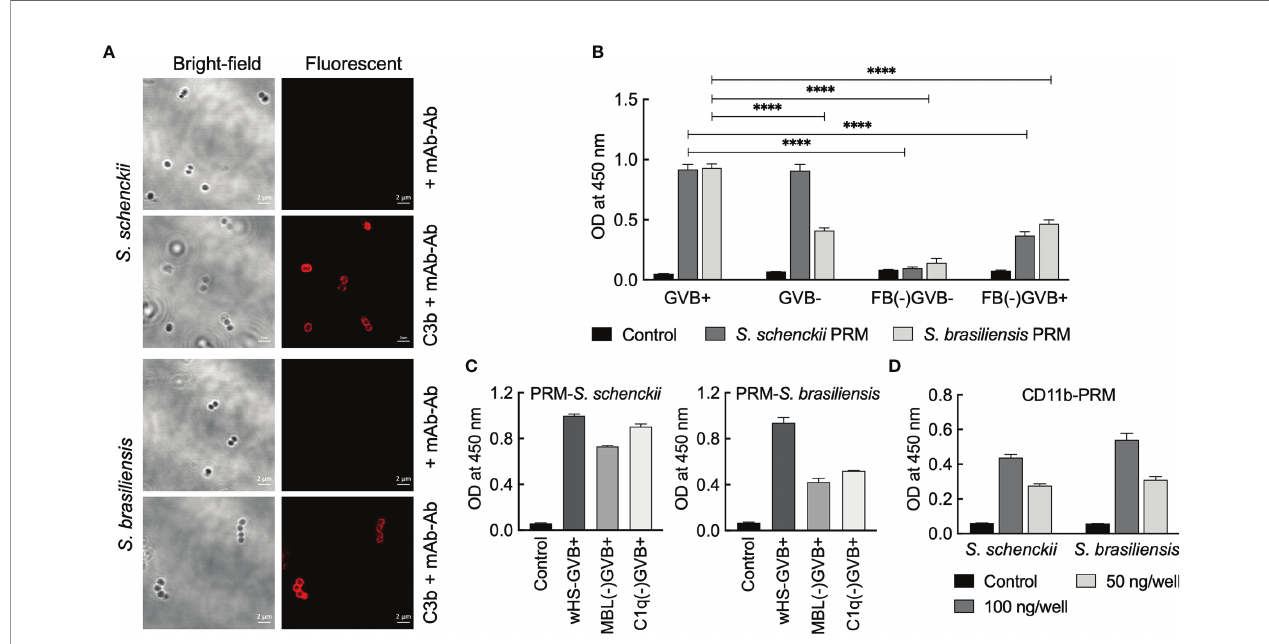
FIGURE 7 | Interaction between complement system and peptidorhamnomannans (PRMs) of Sporothrix species. (A) Sporothrix yeasts were opsonized with C3b and labeled with mouse anti-C3b mAb and mouse TRITC-IgG (Ab). PRMs (50 µg/ml in 50 mM carbonate buffer, pH 9.6) were coated on 96-well plate: their (B, C) C3 activation capacities were determined using GVB+ or GVB- (with EGTA) media using whole/complement factor-depleted human sera. (D ) Interaction with CD11b was determined by sequential addition of CD11b, mouse anti-CD11b mAb, peroxidase-conjugated mouse IgG, and chromogenic substrate for peroxidase (tetramethyl benzidine); colors developed were optically read at 450 nm. For each condition, two independent experiments, in triplicate, were performed. Statistical analysis was performed by ANOVA with Tukey ’ s multiple comparison posttest (****p <